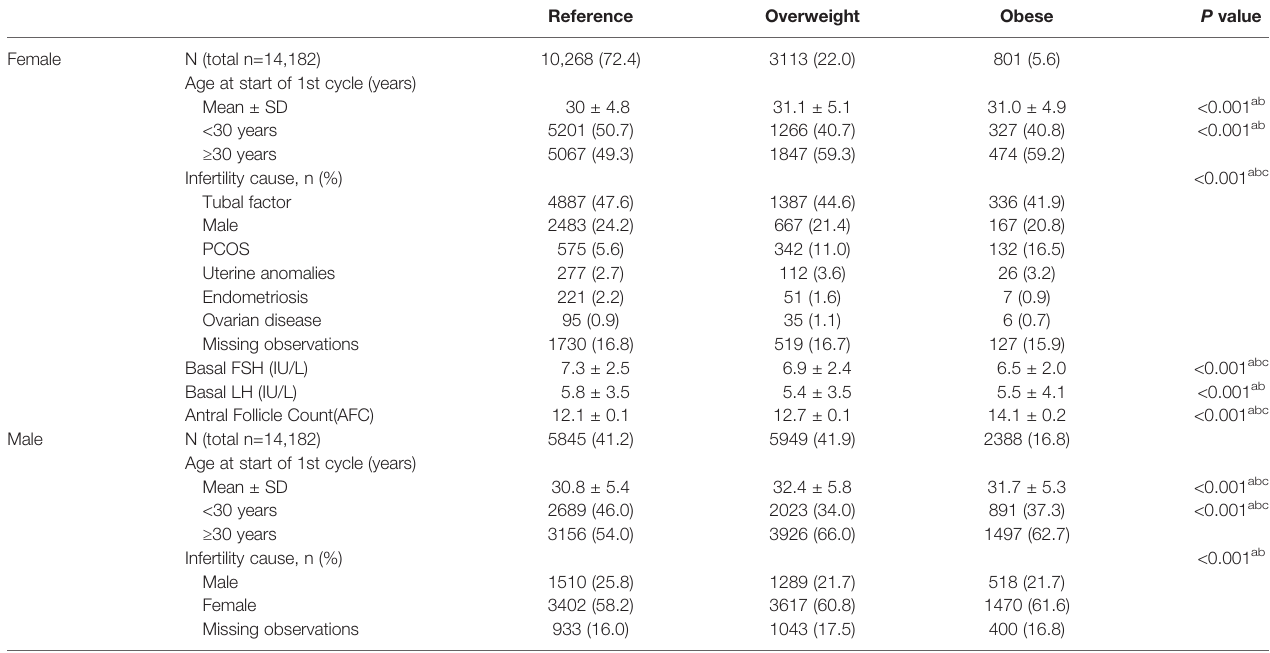
TABLE 1 | Clinical characteristics of the study population according to sex and body mass